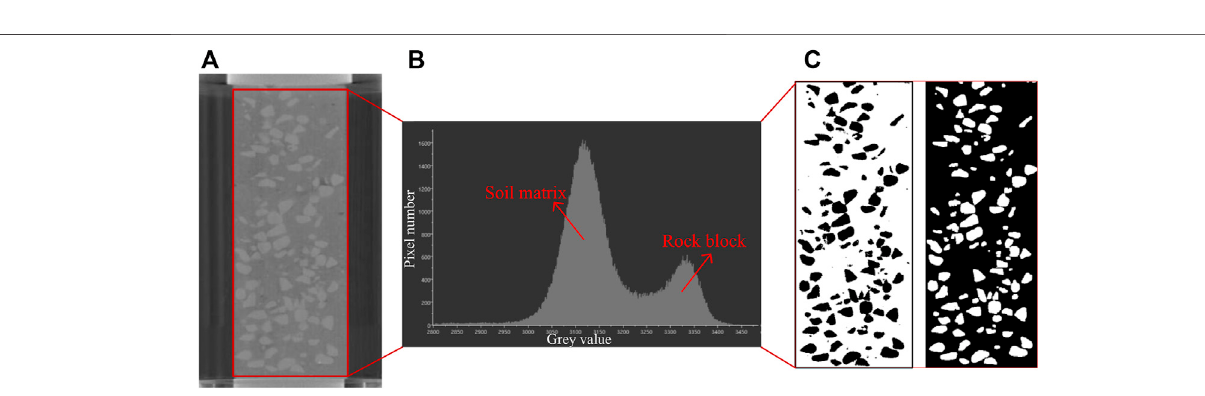
Frontiers in Physics |